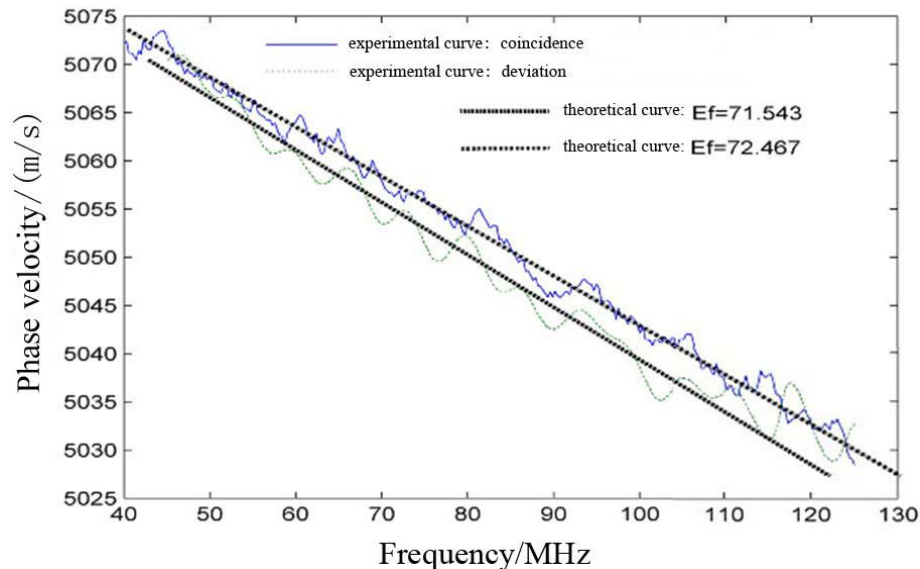
Figure 8. Dispersion curve fitting